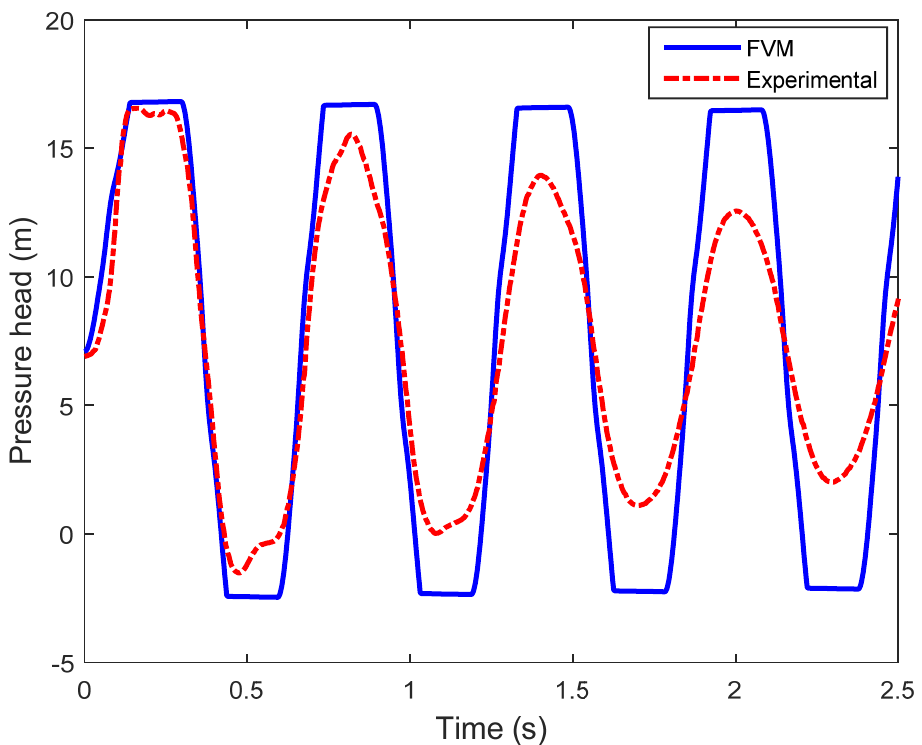
Figure 15. Comparison between the FVM and experimental pressure histories [88].